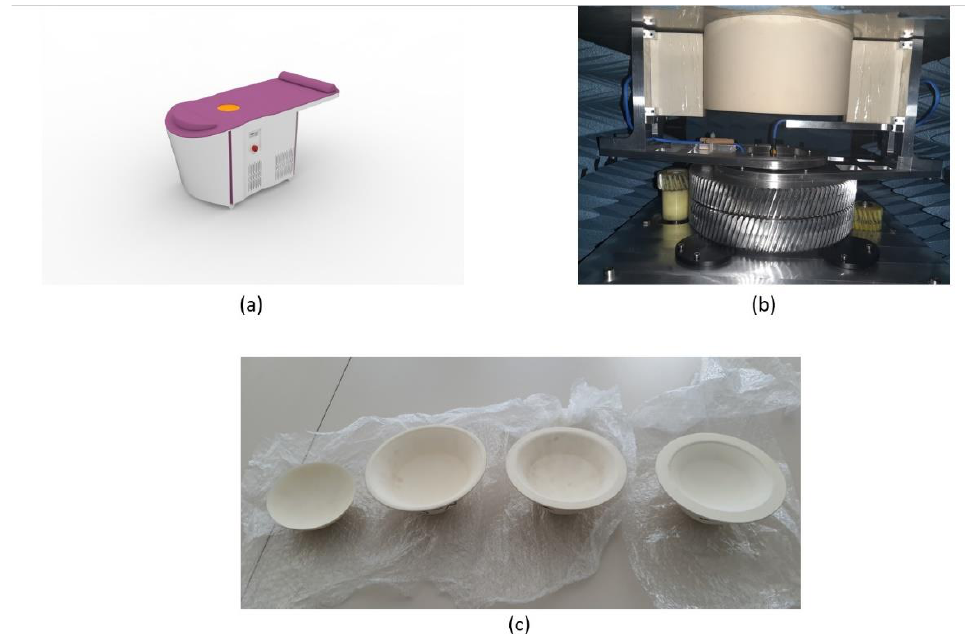
Figure 1. SAFE (Scan and Find Early) microwave breast cancer imaging device: ( a ) SAFE’s new portable device design; ( b ) scanning unit consisting of one transmitting and one receiving antenna rotating around breast holder; ( c ) breast cups intended to match different breast sizes.